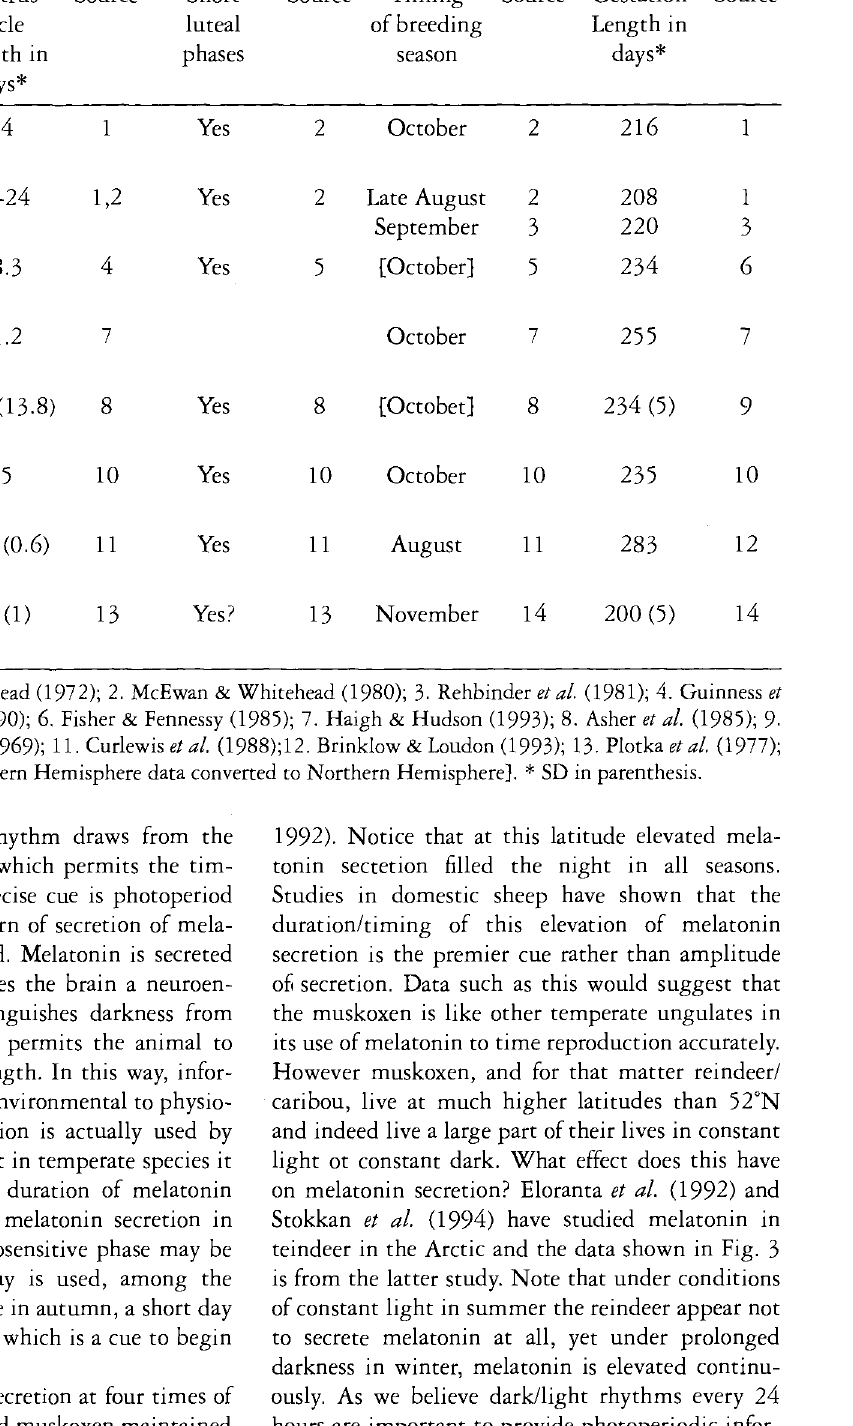
Table 4. Comparison of reproductive characteristics in Cervidae. Short Source Timing Source Gestation Source Species Oestrus Source luteal of breeding Length in cycle Length in days*